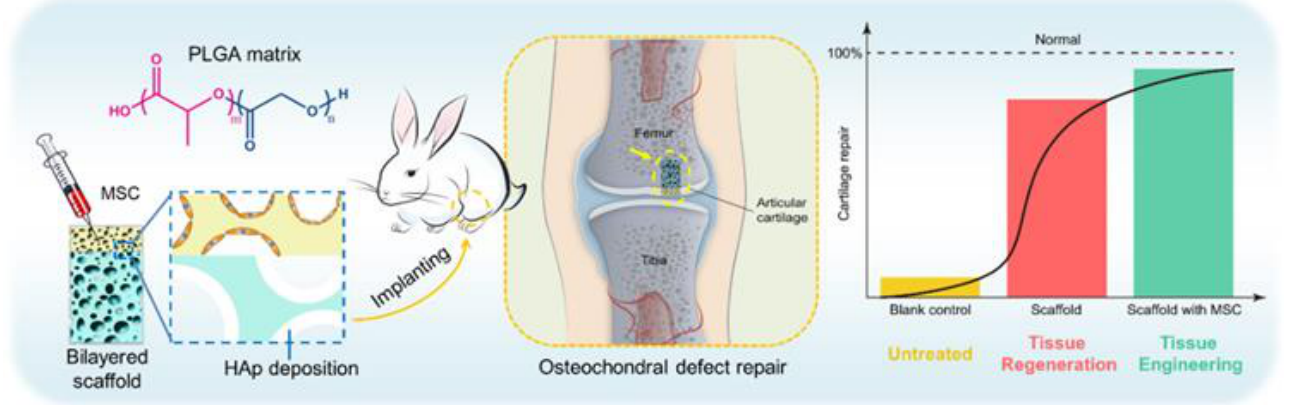
Figure 21. Illustration of hydroxyapatite-based scaffold-induced regeneration of bone. Reprinted from ref. [191], copyright 2018, with permission from the American Chemical Society.